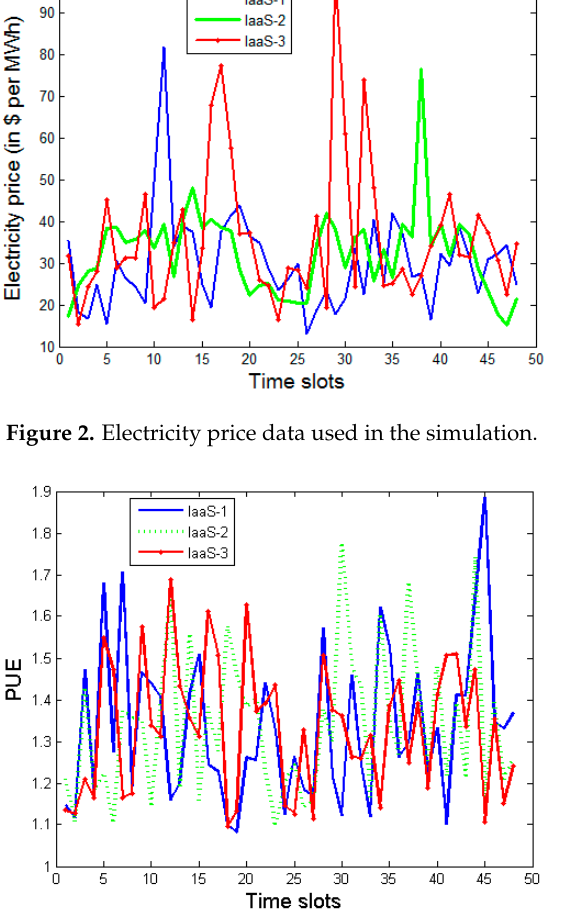
Figure 4. Renewable energy data used in the simulation.